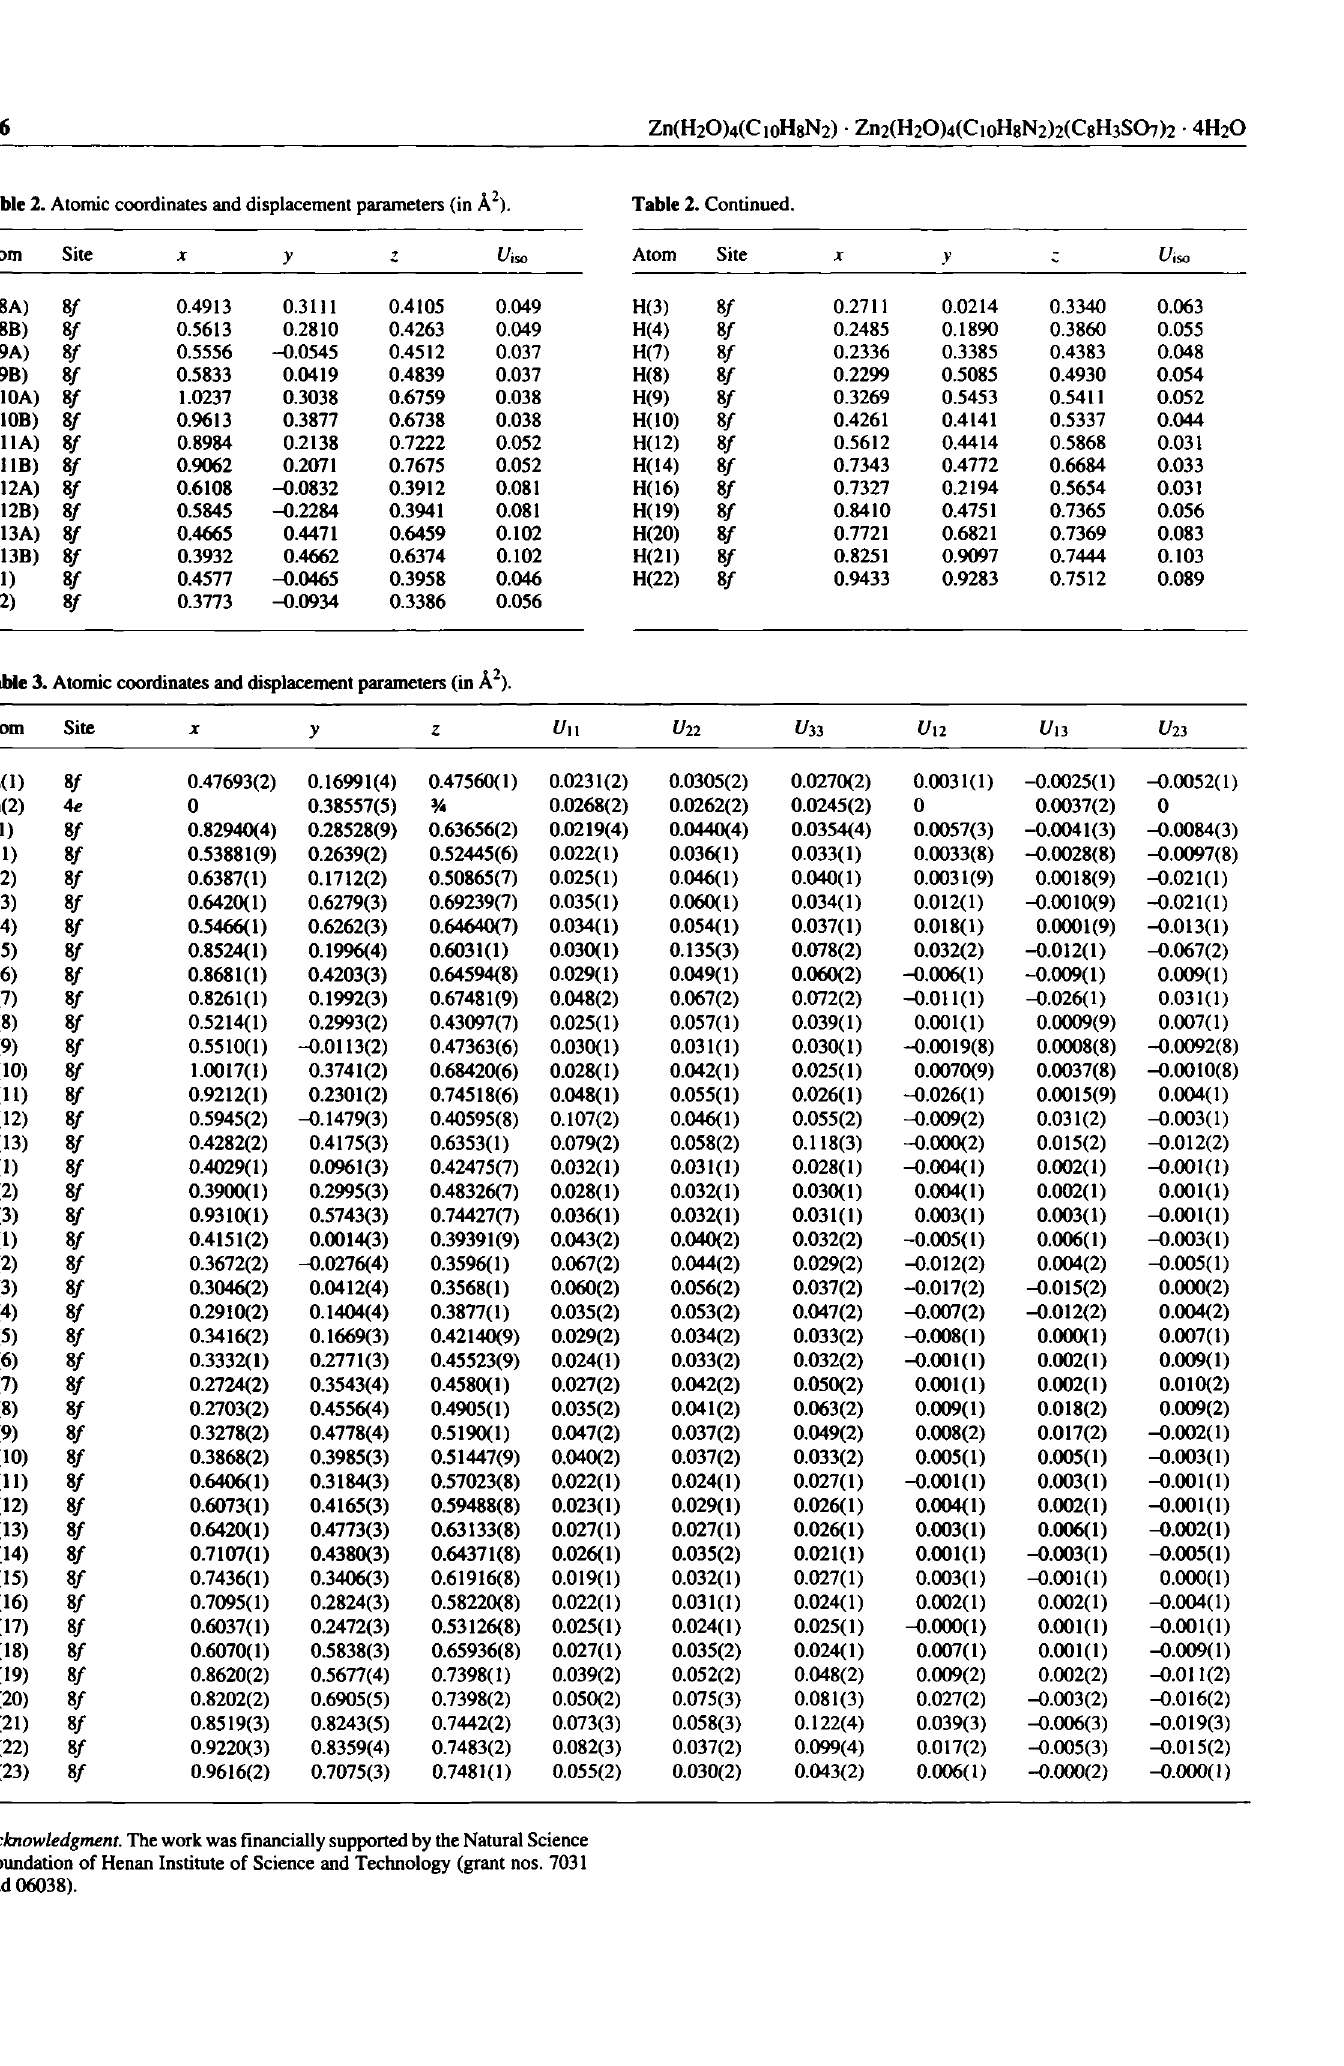
Table 3. Atomic coordinates and displacement parameters (in Â 2